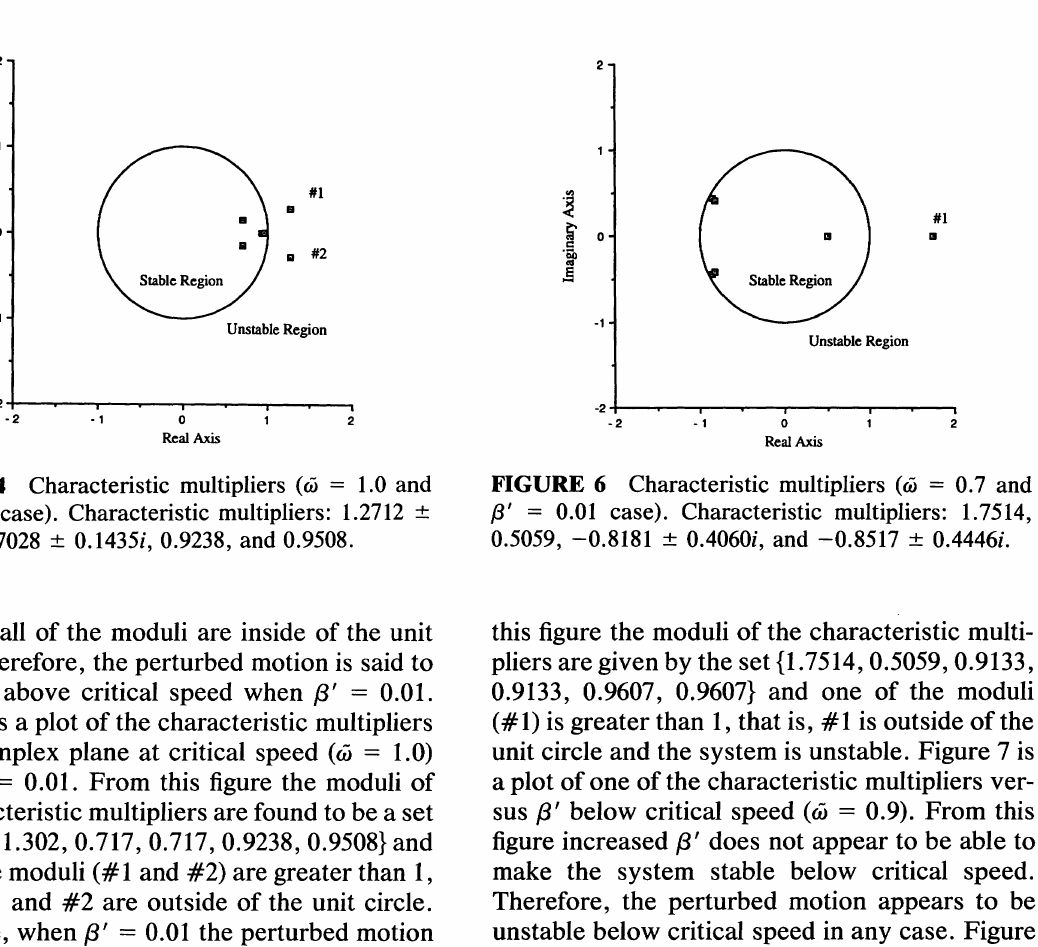
FIGURE 6 Characteristic multipliers (eli = 0.7 and {3' = 0.01 case). Characteristic multipliers: 1.7514, 0.5059, -0.8181 ± 0.4060i, and -0.8517 ± 0.4446i.